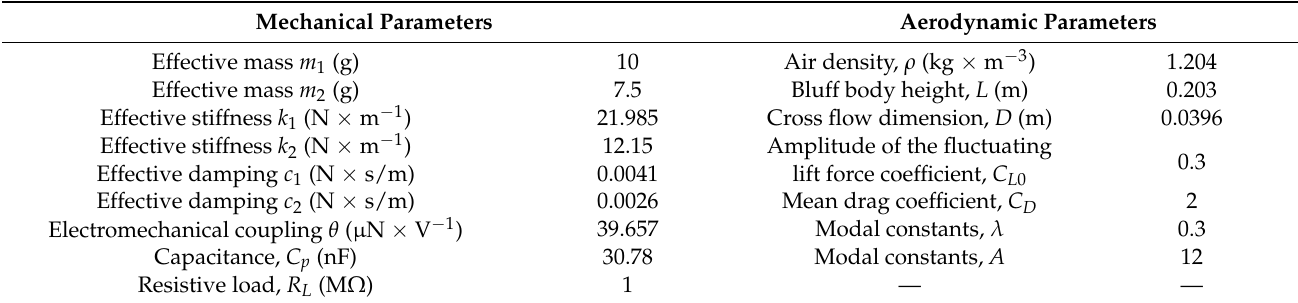
Table 1. Parameters of 2DOF VIVPEH.